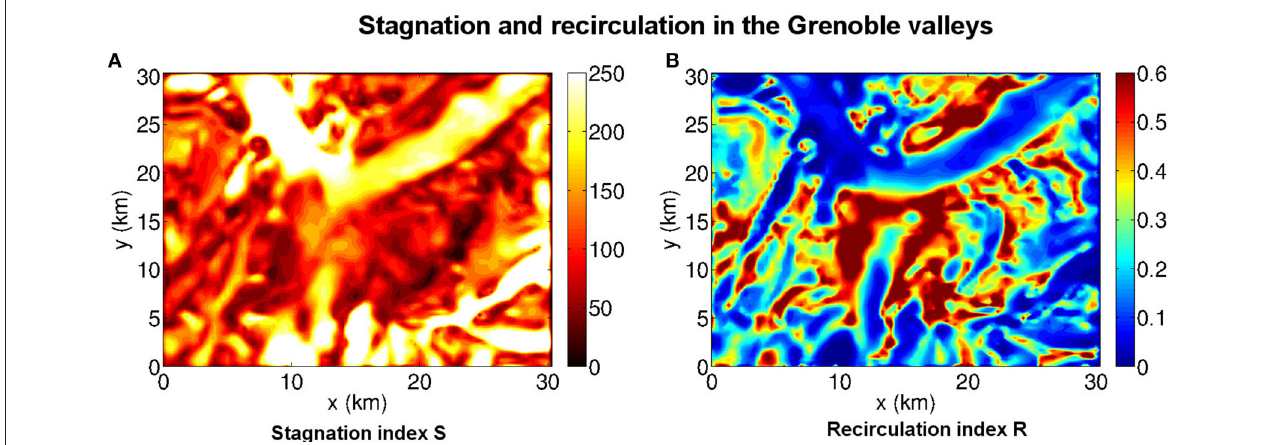
FIGURE 8 | (A) Stagnation index S (in km ) averaged over the first 50 m above the ground and over the 2 days of configuration C2. Stagnation areas appear in red and black. (B) Recirulation index R averaged as S. Recirculation areas appear in dark red. Ventilated areas ( S ≥ 250 km, R ≤ 0.2 ) correspond to areas where S appears in white and R in blue.